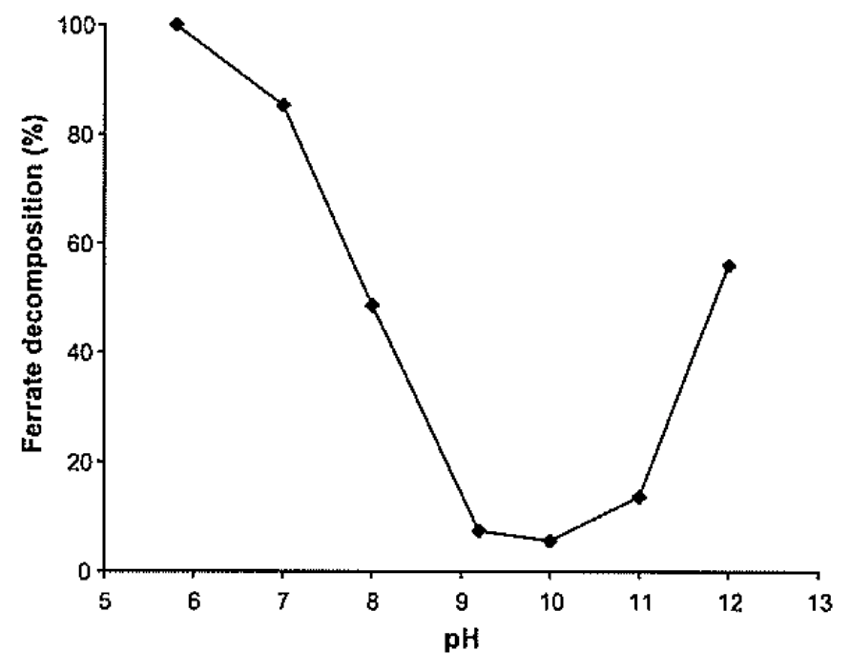
Figure 14. Effect of pH on the rate of decomposition of ferrate(VI) [118]. Oxidative hydrolysis is immediate on contact between ferrate(VI) and water; at pH = 6, decomposition of ferrate is complete after 10 min. Note that, in Figure 10, the rate of decomposition at pH = 12 (close to 60%) is greater than that at pH = 8 (which is 50%). This immediately suggests that freshly prepared ferrate(VI) solutions should be stored at pH = 10, the pH value at which decomposition is slowest (see Figure 10), although many synthetic chemists seem to prefer an alkaline pH rendered by 1 M NaOH, that of pH = 14. Even higher concentrations of alkali had been used, e.g., 10 M KOH by Licht et al. [24]. However, the number of OH − ions present in the hydration sheath of the Fe(VI) anion will be limited by electrostatic repulsion. Do pH values drop so rapidly during redox reactions that so much caustic soda is required? It also needs be mentioned that there is scant rate data in the literature in the pH range 12 < pH < 14. Does decomposition stop abruptly at pH > 12, or does it proceed so sluggishly that the minute fraction of ferrate lost is of